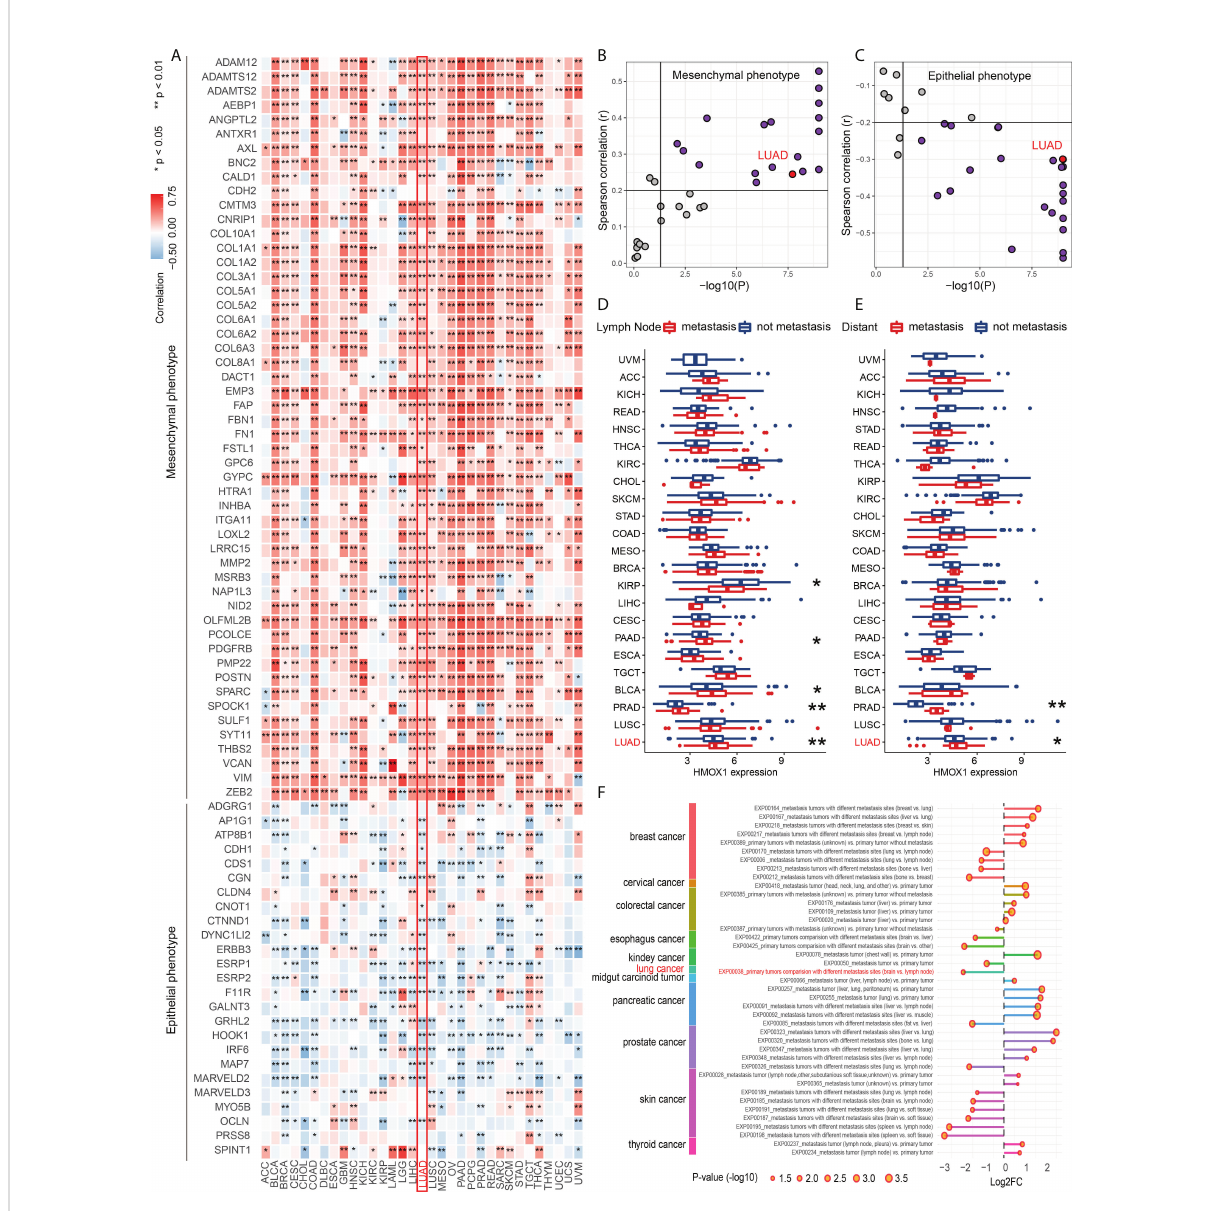
FIGURE 1 The effect of HMOX1 on metastasis across cancer types. (A) Correlation between HMOX1 and 77 epithelium-mesenchymal transition (EMT) signature genes. (B) Correlation between HMOX1 and mesenchymal phenotype scoring. (C) Correlation between HMOX1 and epithelial phenotype scoring. (D) Difference in HMOX1 expression between lymph node metastasis and without metastasis groups. (E) Difference in HMOX1 expression between distant metastasis and without metastasis groups (F) Multiple types of metastasis comparisons for the HMOX1 expression in the HCMDB database. *P < 0.05; **P <